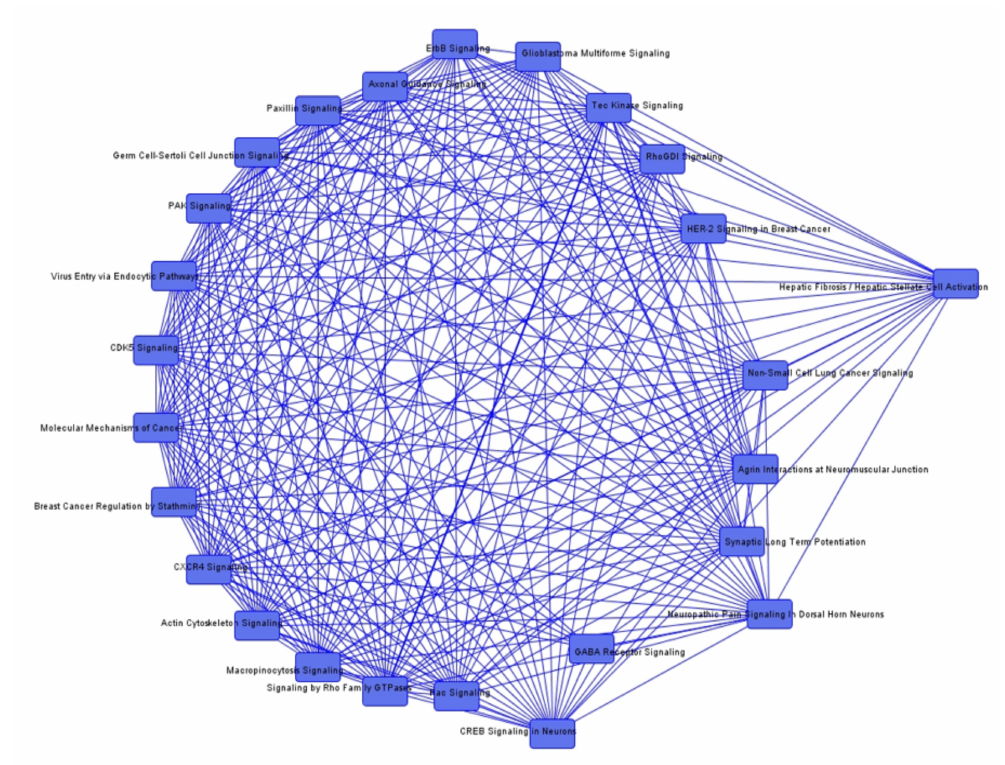
Figure 1. Overlapping canonical pathways in irradiated recurrent vs. non-irradiated neurofibromatosis type 2 (NF2) associated vestibular schwannomas (VS).